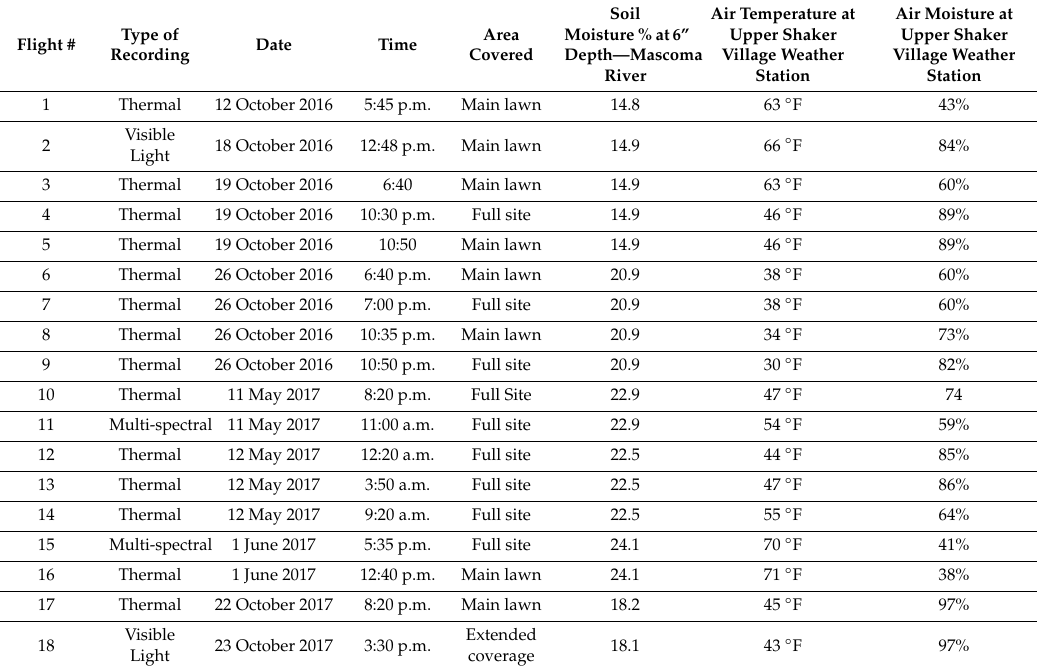
Table 1. Flights at Enfield Shaker Village (all times in